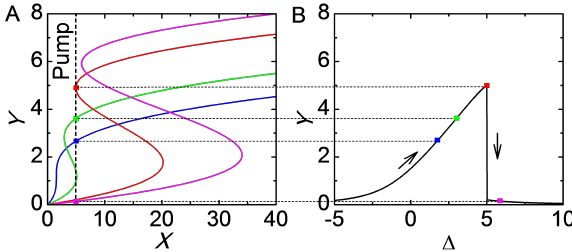
Figure 5: Illustration of the intracavity pump power when phase detuning is continuously increased. (A) Intracavity power versus input pump power (i.e. the bistability curve) for different phase de- tunings. (B) Intracavity power versus phase detuning for the fixed pump power (X) indicated by the dashed vertical line in (A). The in- tracavity power stays on the upper branch before it suddenly drops down to the lower branch. Adapted by permission from Macmillan Publishers Ltd: Nature Photonics [46], copyright 2015.